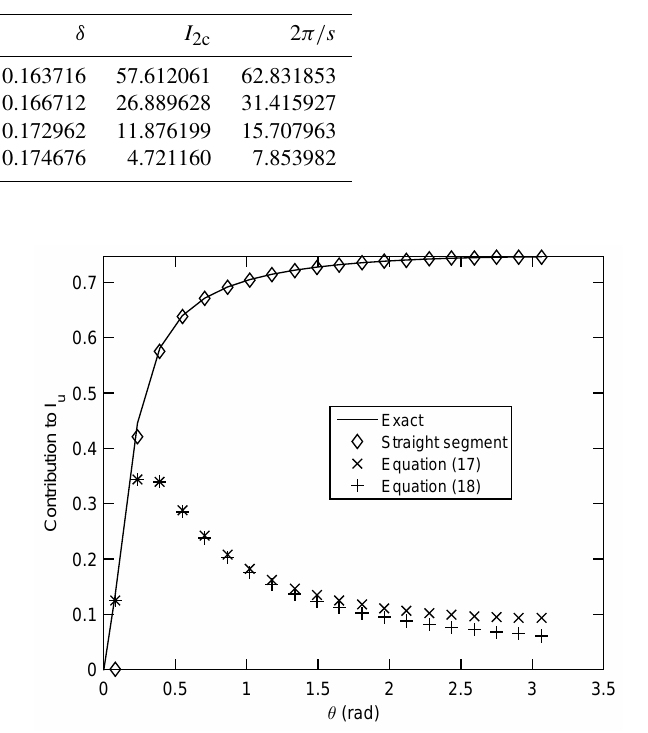
Figure 4. Relative error of the straight segment approximation for the conditions in Table 1 ( θ 0 = 0). + : s = 0 . 1; ◦ : s = 0 . 2; × : s = 0 . 4; : s = 0 . 8. The top group of symbols show the errors for the first half of the rings that contain the aligned segments, 0 ≤ | θ | ≤ π/ 2, and the bottom group covers π/ 2 ≤ | θ | ≤ π . N s = 20 , 40 , 80, and 160.